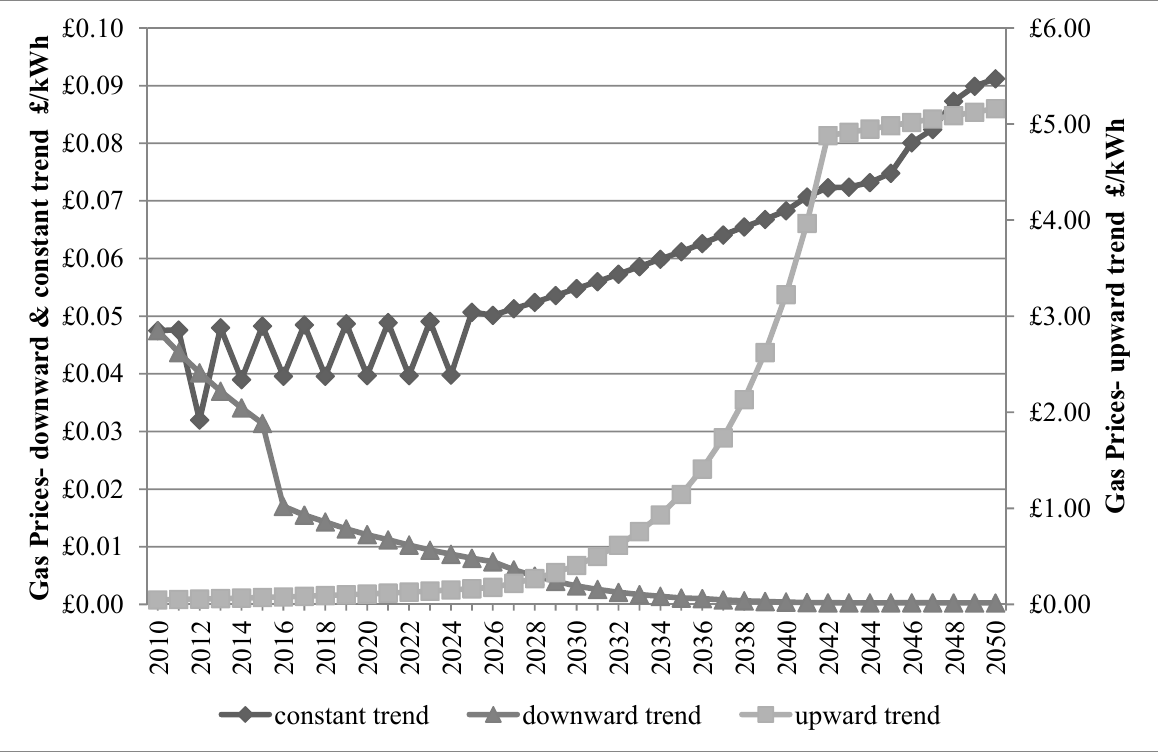
Figure 12. Predicted possible Index upwards or downwards prices for gas.